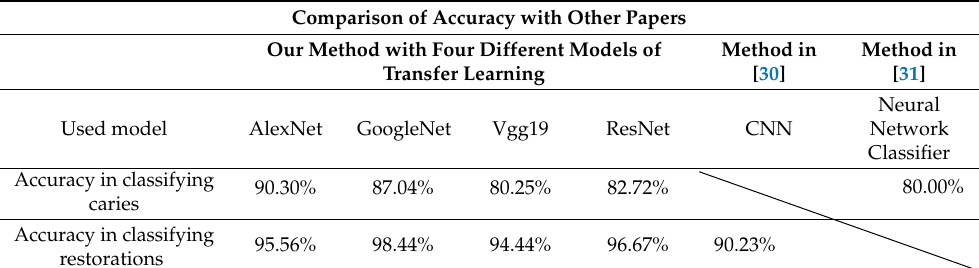
Table 12. Comparison of accuracy with other